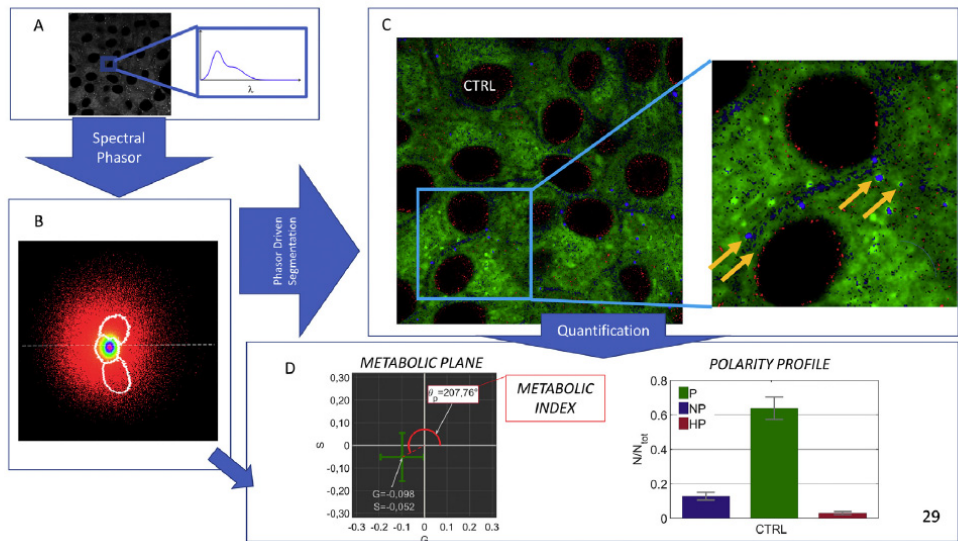
Figure 4. Workflow of the method based on the phasor driven segmentation of Nile Red spectral images. INS-1E cells were maintained at 11 mM glucose received 300 µM palmitic acid for 16 h. ( A ), Nile Red spectral images of live INS-1E cells. Each pixel of the spectral image is associated with the Nile Red emission spectrum. ( B ), Phasor plot generation: the cloud appears as broad and elliptical, because the co-existence of the three classes of lipids (NP, neutral lipids; P, polar lipids and HP, highly polar lipids), which are simultaneously present in the cells. By selecting on the phasor plane the domains corresponding to the three classes (white lines), it becomes possible to remap them to the original fluorescence image. ( C ), Segmentation of the three lipid classes: NP are reported in Blue, P in Green, HP in red. In the magnification, lipid droplets are visualized as spherical particles. P lipids are also localized in the plasma membrane, of which phospholipids is the main component. ( D ), Extraction of the angle θ P formed by the center of mass of the cloud in the phasor plot with the g-axis provides information about the average polarity. From the segmented channels, the fractional contribution of the different lipid classes, in terms of the relative fraction of pixels belonging to a particular class was retrieved. Copied with permission from [21].